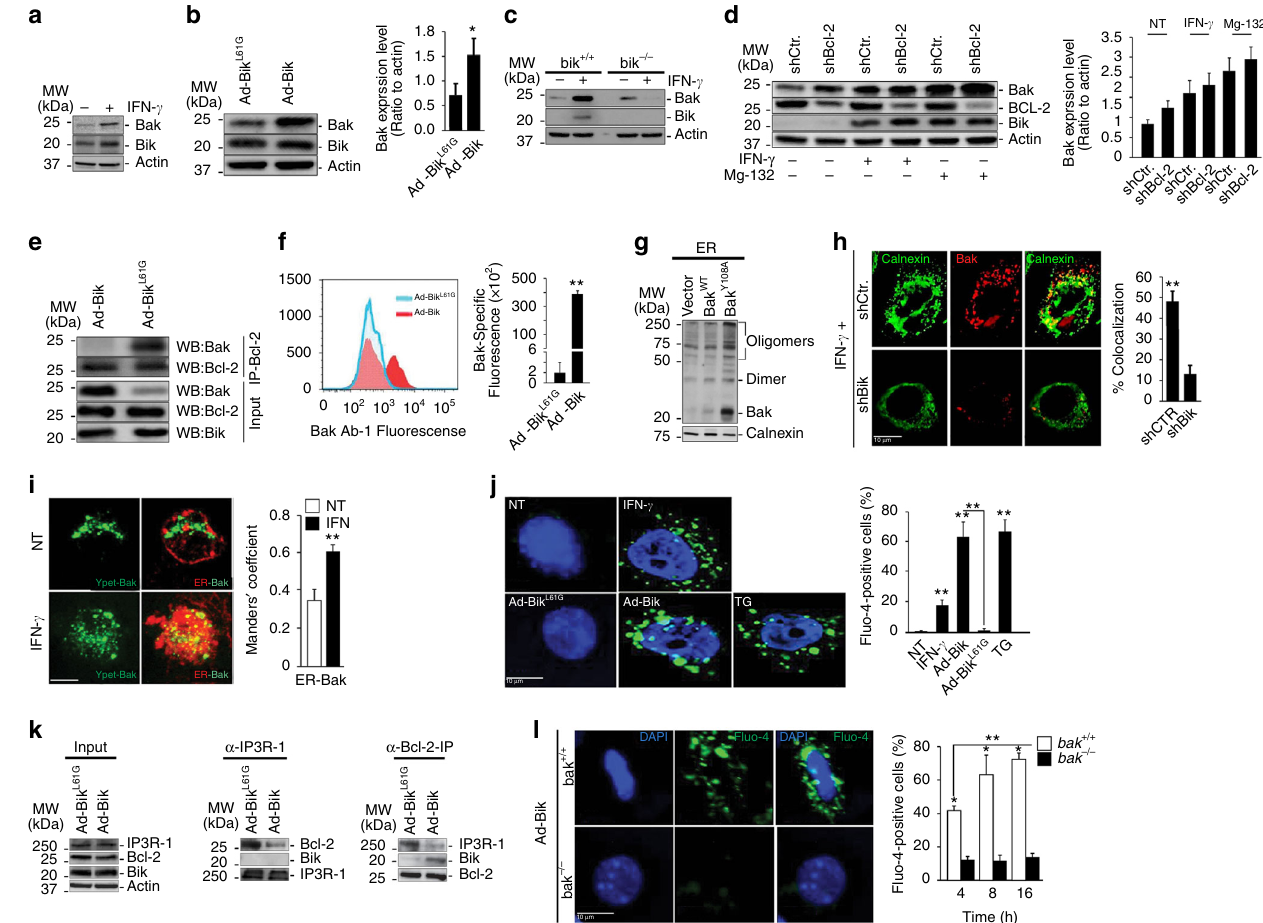
Fig. 1 Bik activates and translocates Bak to the ER. HAECs were treated with 50 ng/ml human recombinant IFN- γ or medium alone as controls ( a ) or infected with 100 MOI Ad-Bik or Ad-Bik L61G ( b ), and 24 h later protein lysates were analyzed for changes in the expression of Bak by western blotting. The fold change in Bik level was analyzed by densitometry. c MAECs from bik + / + or bik − / − mice were treated with IFN - γ for 48 h and the levels of Bik and Bak protein levels analyzed by western blotting. d HAECs were transiently infected with retroviral vectors for shCtr or shBcl-2 and treated with 50 ng/ml IFN- γ or medium alone as control for 48 h or treated with 10 µ M MG132 for 24 h and protein lysates were analyzed for the expression level of Bak, Bcl-2, Bik and actin proteins by western blotting. e HAECs were infected with 100 MOI Ad-Bik or Ad-Bik L61G , and immunoprecipitates of protein lysates with anti-Bcl-2 antibody were probed for Bak and Bcl-2 levels by western blotting. f HAECs were infected with Ad-Bik or Ad-Bik L61G and 24 h later analyzed for increases in active Bak using the Ab-1 antibody that is speci fi c for activated Bak using FACS. g HCT116 cells retrovirally transduced with empty vector, Bak WT or Bak Y108A were infected with 100 MOI Ad-Bik. The ER fractions were analyzed with anti-Bak antibodies. Calnexin was used as a marker for equal loading of ER proteins. h Representative photomicrographs of HAECs stably expressing shCtr or shBik treated with 50 ng/ml IFN- γ for 48 h fi xed with paraformaldehyde and immunostained for activated Bak and calnexin. Percent of cells with Bak localized to the ER was quanti fi ed after counting at least 200 cells for each experiment. Scale bar, 5 µ m. i Representative micrographs of HCT116 bax − / − bak − / − cells transfected with F3YpetR-F3hBak (green), followed by treatment with 50 ng/ml IFN- γ or media alone. Cells were stained with calnexin for ER (red) and confocal images of 3D reconstructions of ER were acquired. Areas of Bak-ER co-localization were quanti fi ed by Manders ’ coef fi cient, means and SEM ( n = 3 experiments, 40 cells per experiment). Scale bars, 5 μ m. j HAECs were treated in the presence of 20 µ M pan-caspase inhibitor Q-VD-OPh with IFN- γ or nothing, thapsigargin (positive control), Ad-Bik or Ad-Bik L61G for 4 h, and stained with Ca 2+ - fl ux indicator, Fluor-4 (green) and counterstained with DAPI (blue) for nuclei. k HAECs were infected with 100 MOI Ad-Bik or Ad-Bik L61G and 24 h later protein lysates immunoprecipitated using anti- IP 3 R-1 or anti-Bcl-2 antibodies. Input and immunoprecipitates were probed for Bcl-2, Bik, and IP 3 R-1 levels by western blotting. l De fi ciency of bak impairs Ad-Bik-induced ER Ca 2+ ef fl ux. MAECs from bak + / + or bak − / − mice were infected with Ad-Bik for 4, 8 and 16 h, and stained with Ca 2+ -ef fl ux indicator, Fluo-4. ( n = 3 experiments, with > 200 cells analyzed per condition). Differences between two groups were assessed for signi fi cance by Student ’ s t test. ANOVA was used to perform pair-wise comparison of the data from more than two groups followed by Fisher least signi fi cant difference test. Graphs show mean ± SEM; * = P < 0.05; ** = P <